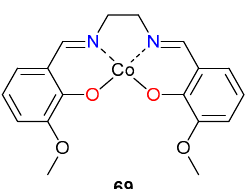
Figure 12. Co(II) salen catalyst for the ROP of L -lactide [57].